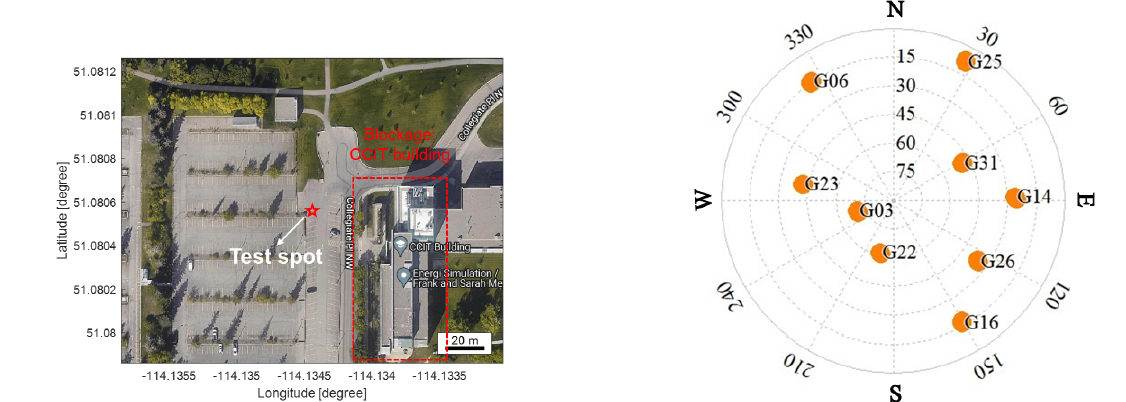
Figure 11. Semi-open-sky test spot (Google Map show) and the sky plot of available GPS satellites.